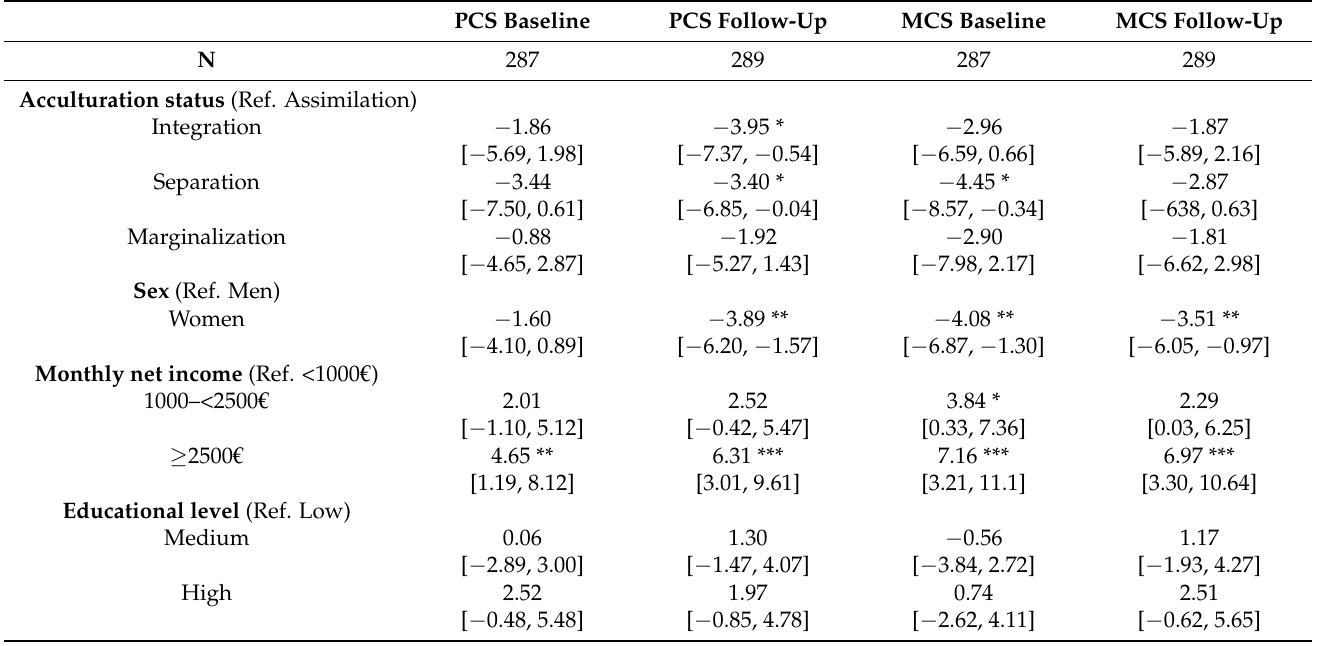
Table 2. Cross-sectional analysis of the association between acculturation status and health-related quality of life at baseline and follow-up (linear regression). PCS Baseline PCS Follow-Up MCS Baseline MCS Follow-Up N 287 289 287